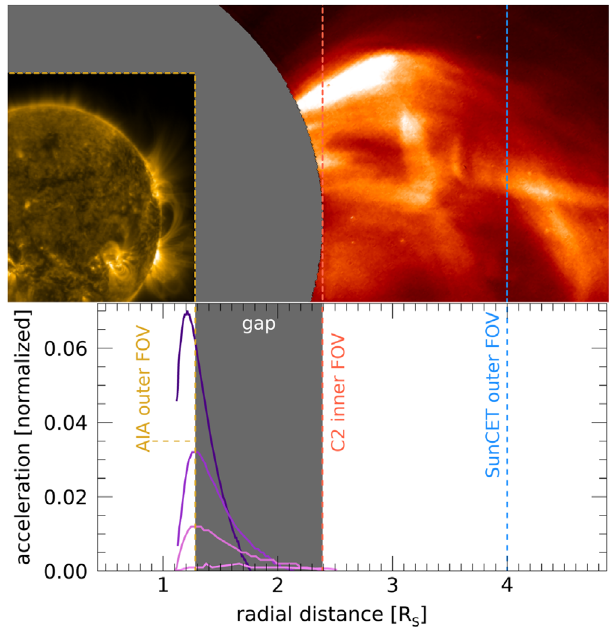
Fig. 2. Top: Composite of SDO/AIA 171 Å image and SOHO/ LASCO/C2 white-light coronagraph image. The longstanding obser- vational gap is shown in dark grey. Bottom: Modeled acceleration pro fi les of torus instability CMEs, adapted from Török and Kliem (2007) Fig. 3. The different curves result from different background magnetic fi eld decay index pro fi le assumptions, with each higher acceleration peak corresponding to a larger decay index pro fi le. Most of the acceleration occurs in the observational gap that SunCET fi lls.